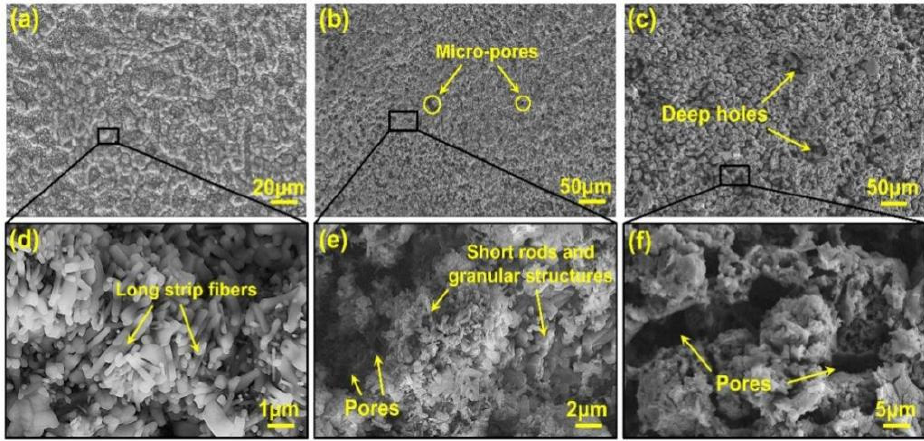
Figure 7. Surface SEM images of the tested samples: ( a ) and ( d ) H2; ( b ) and ( e ) H3; and ( c ) and ( f ) H4.